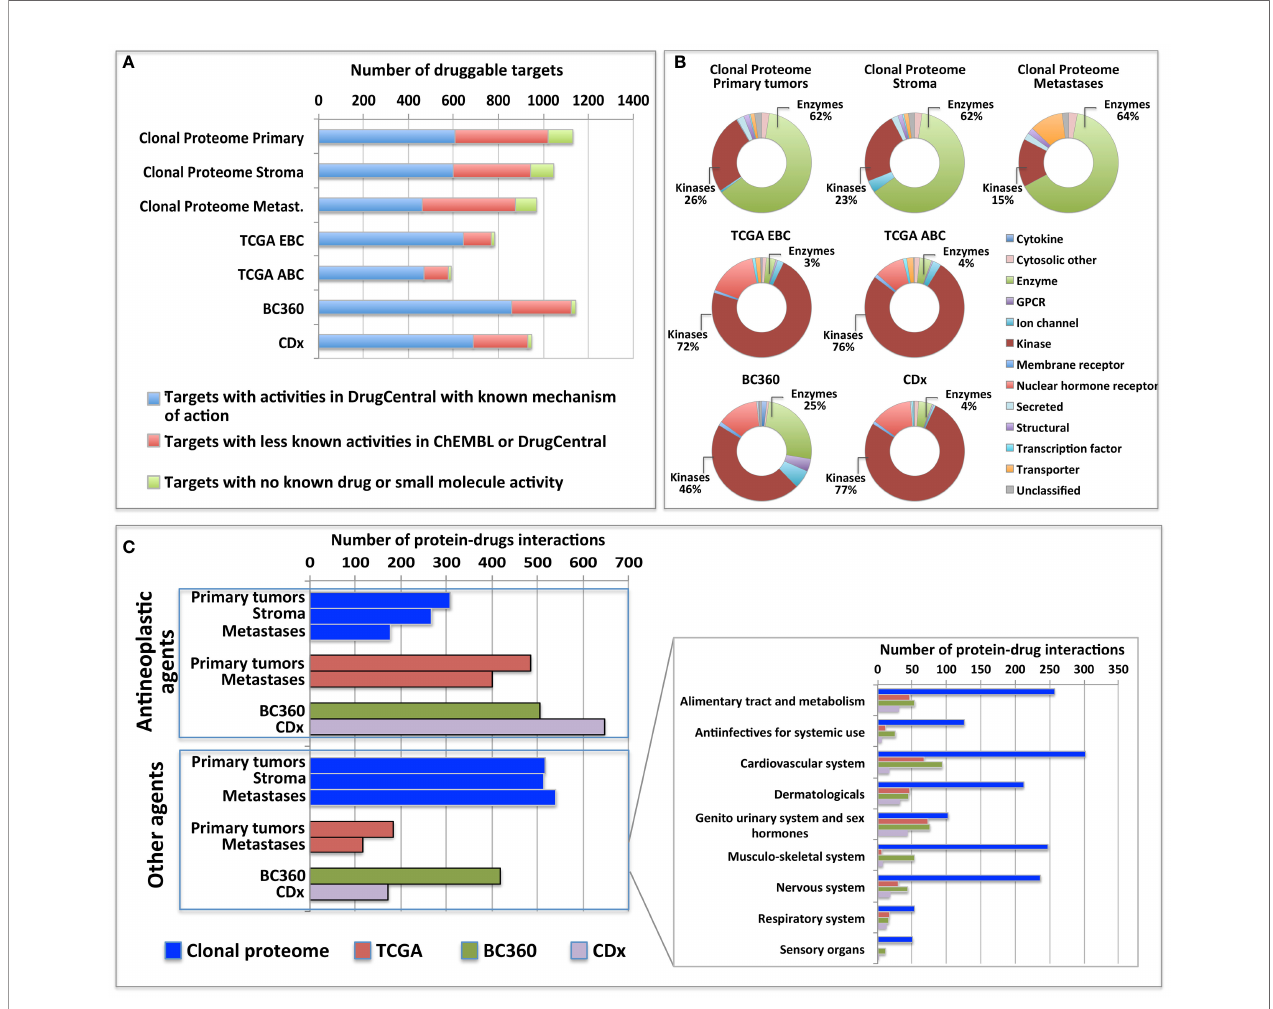
FIGURE 4 | Druggable targets identi fi ed (A) in the clonal proteome, TCGA, CDx, and BC360 datasets using DrugCentral, and the druggability level as de fi ned by IDG-KMC (https://druggablegenome.net/ProteinFam). Known targets (Tclin) are in blue, less known targets are in orange (Tchem) and targets with no known drug are in red (Tbio). (B) Target class distribution among the datasets, and (C) matching drugs, both approved antineoplastic drugs or other drugs (non-anticancer drugs) described using the ATC classi fi cation. ABC, advanced breast cancer; EBC, early breast cancer; Metas,